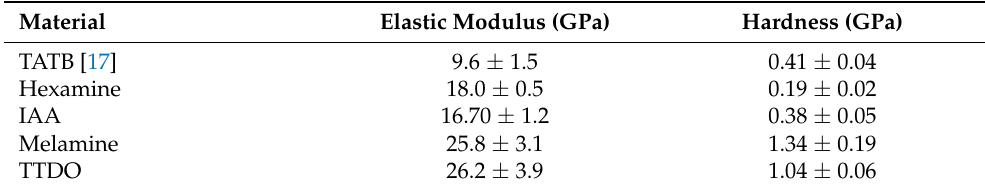
Table 3. Hardness and elastic modulus values for TATB and each mock candidate from which suitable crystals could be